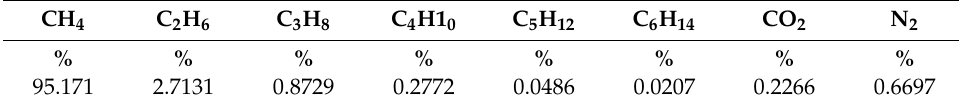
Table 4. Natural gas composition in % vol. (adapted from